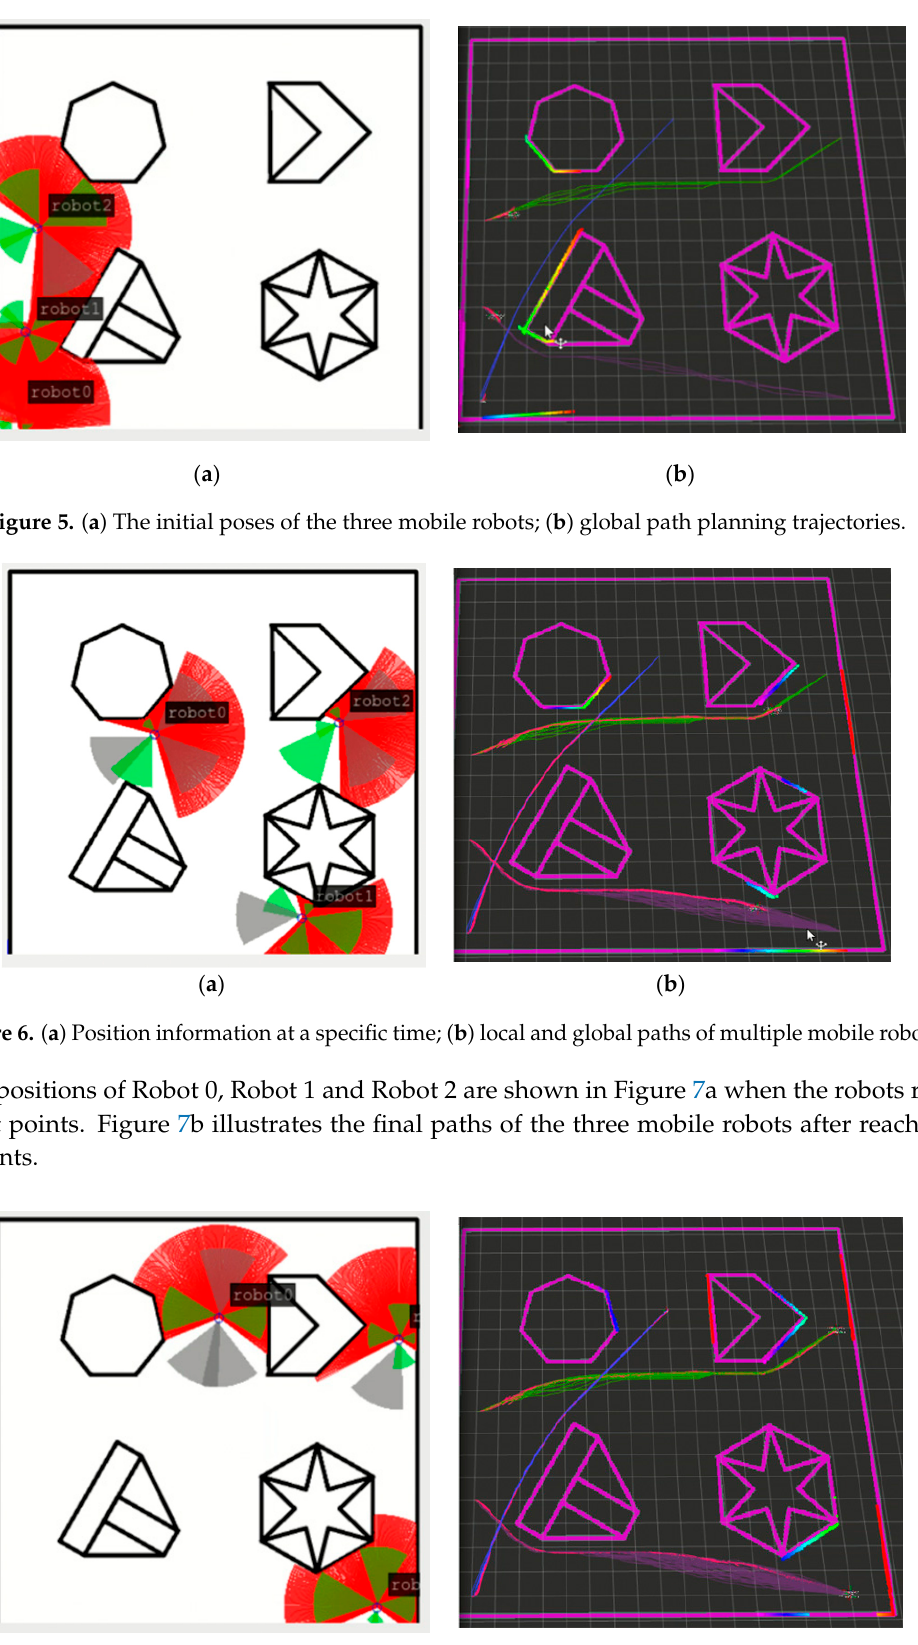
( b ) Figure 4. ( a ) The initial poses of the three mobile robots; ( b ) simulation visual interface of multiple mobile robots. The global path planning trajectories of the three mobile robots are shown in Figure 5. As shown